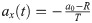
An intuitive explanation of Chapman’s strategy.(Adapted from [7]). It states that for an ideal parabolic ball trajectory and an agent moving towards the impact point with constant velocity ax(t)=-a0-RT the tangent of the vertical viewing angle θ(t) = tan α(t) rises with a constant rate. This is illustrated by the blue line segments whose length is linear both in θ since st = (R + D0)θ(t) and in time since snt = nst; hence, θ is linear, too. We will show this formally in Section 4.2.